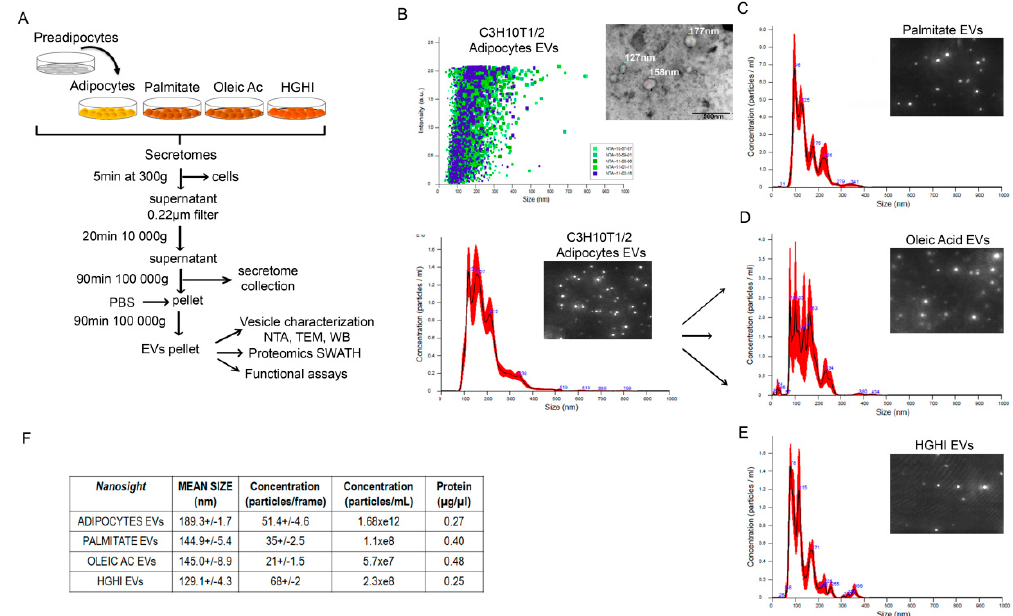
Figure 1. Adipocytes secrete extracellular vesicles whose size and concentration varies with metabolic insults. Schematic representation of vesicle isolation protocol by differential centrifugation and further analysis from secretomes obtained from control C3H10T1/2 adipocytes and after metabolic insults with palmitate (500 µM, 18 h), oleic acid (1 mM, 24 h) and high glucose (4.5 g/L)/high insulin (5 µg/mL, 24 h) treatment (HGHI) ( A ). Nanoshight analysis of isolated vesicles showing size distribution (nm) and particle dispersion ( B – E ); a representative TEM image of vesicles isolated from differentiated adipocytes is also shown ( B ). Mean size (nm) and estimated concentration is shown as particles/frame, particles/mL of secretome, and protein concentration (µg/µL) obtained after centrifuging secretomes from 18 cell plates of 35 mm ( F ). NTA: nanoparticle tracking analysis; TEM: transmission electron microscope; WB: western blot.